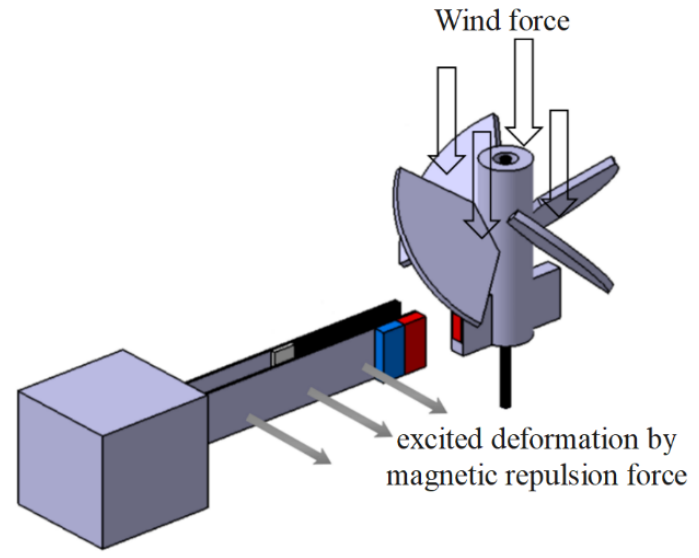
Figure 2. Schematic of the DES VEH.